Question: Write a caption explaining this figure to a reader.
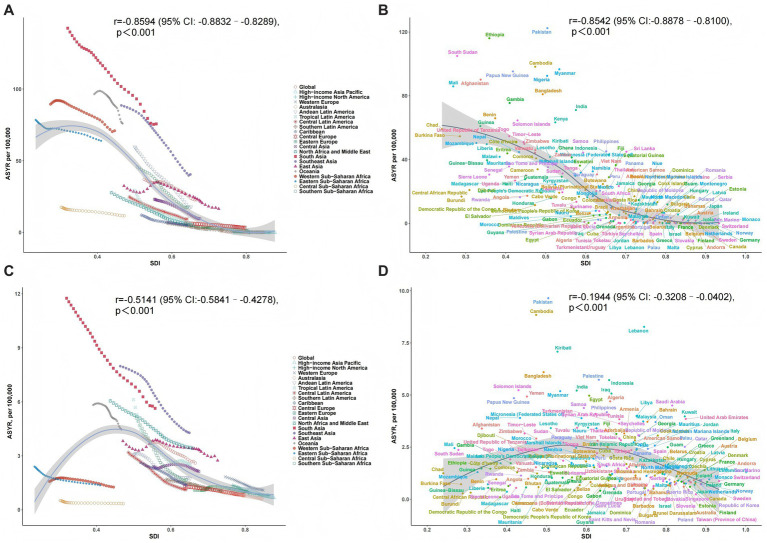
Answer: Association between SDI and ASYR for cataract attributable to HAP (A, B) and smoking (C, D) . (A, C) Trends in 21 regions, 1990–2021. (B, D) 2021 estimates for 204 countries and territories. The blue line represents the expected ASYR based solely on the SDI. ASYR, age-standardised YLD rate; SDI, Socio-demographic Index; HAP, household air pollution.